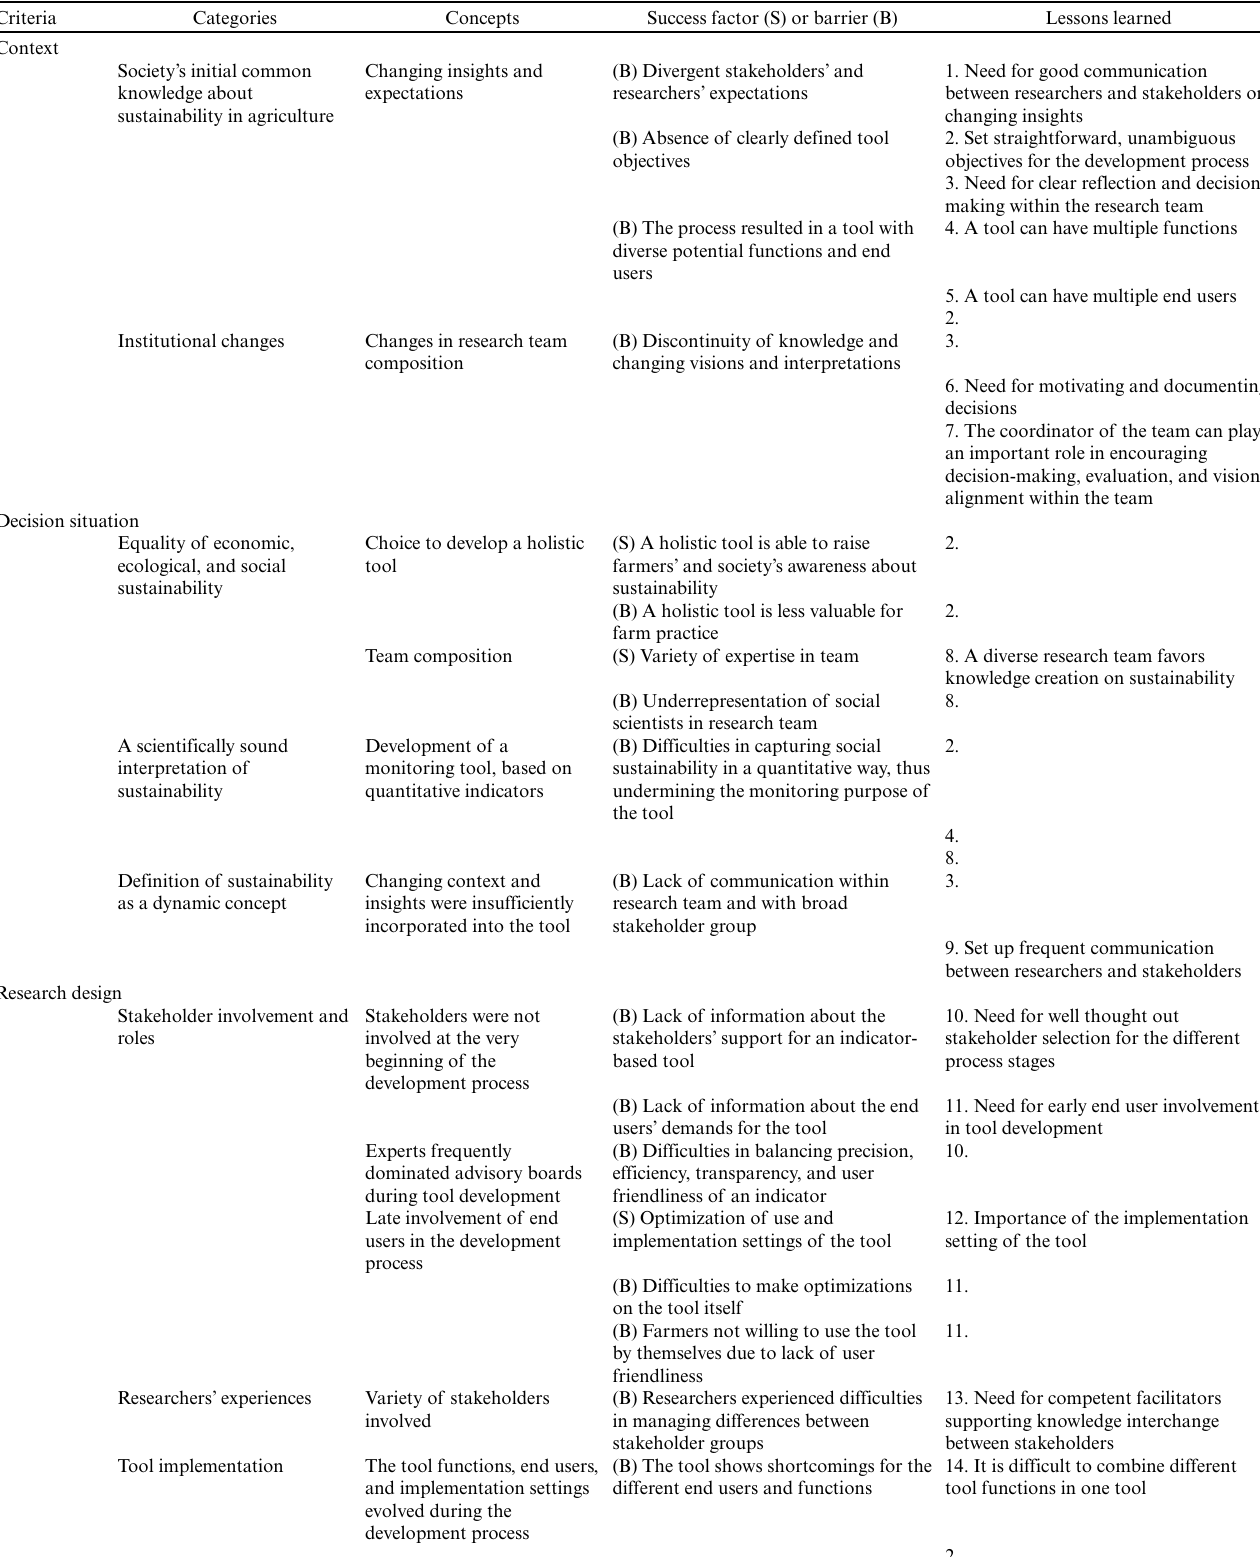
Table 1 . Barriers and success factors for MOTIFS’ adoption in